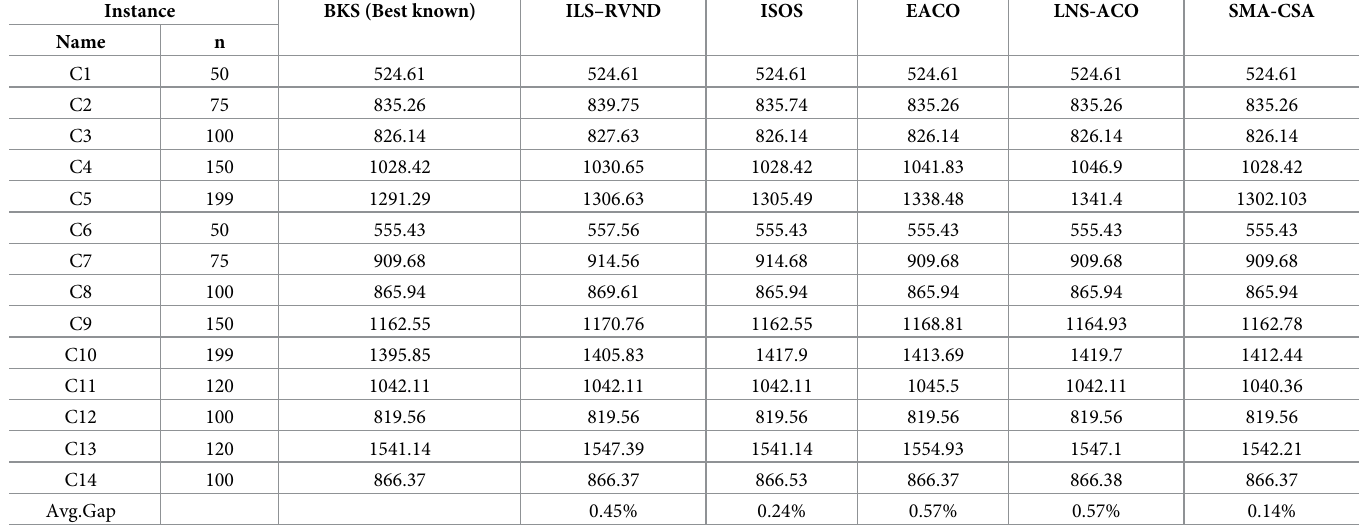
Table 13. Comparison results on Christofides’s benchmark datasets of CVRP with advanced algorithms.